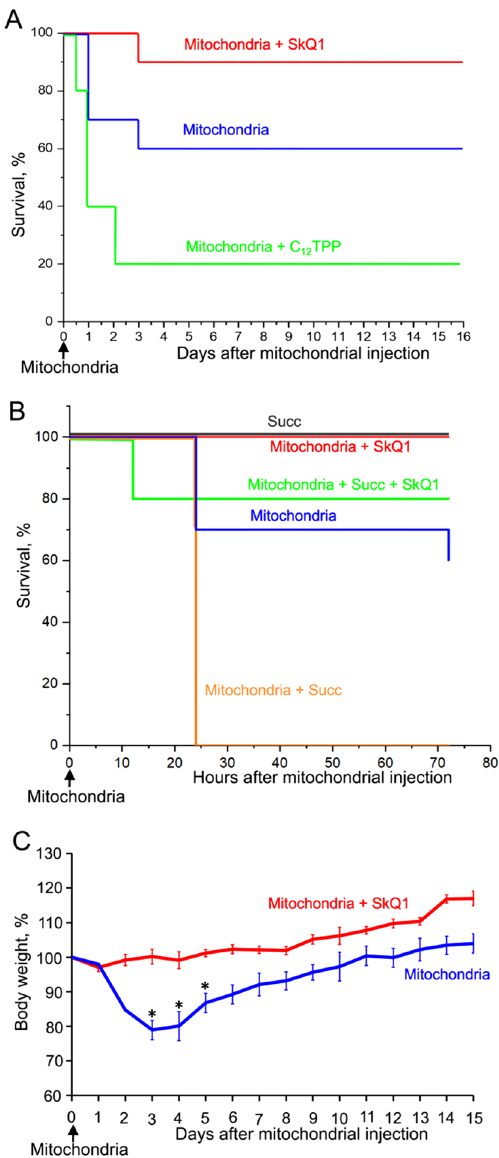
Figure 4. SkQ1 prevents the rapid death of mice after injection of mitochondria (10 mg protein/kg body weight) into the tail vein. ( A–C ) SkQ1 or C 12 TPP (1.5 μmol/kg) was administered intraperitoneally daily for 5 days before and after mitochondrial injection. ( B ) 5 mM succinate (Succ) was added to mitochondria prior to injection. ( C ) Dynamics of mouse body weight after injection of mitochondria. Standard deviations are shown; * p < 0.05. The number of mice in each group treated with SkQ1 was 6, and in groups without SkQ1,